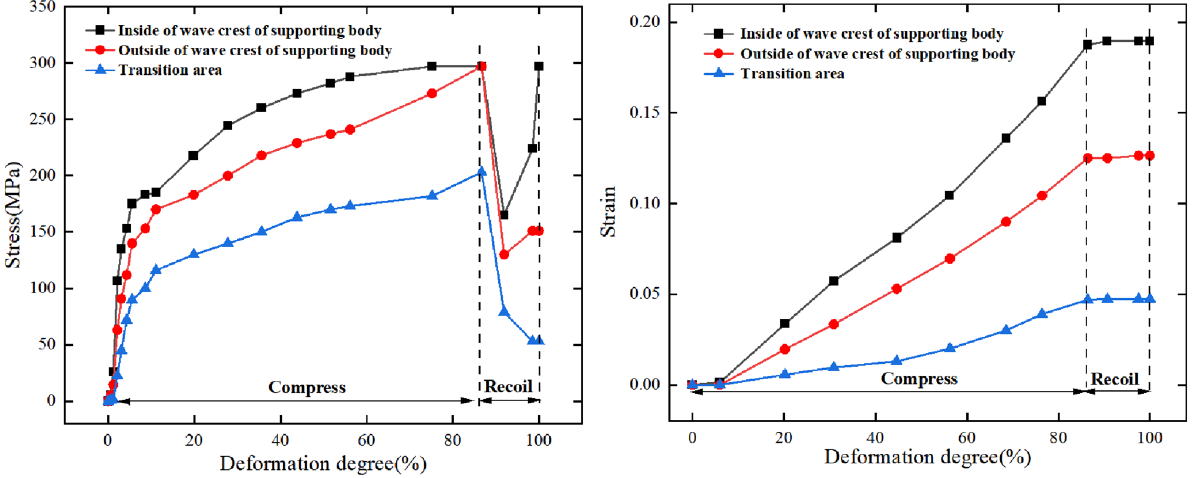
Figure 7. The equivalent stress ( a ) and equivalent strain ( b ) distribution contours for the stent after spring-back.